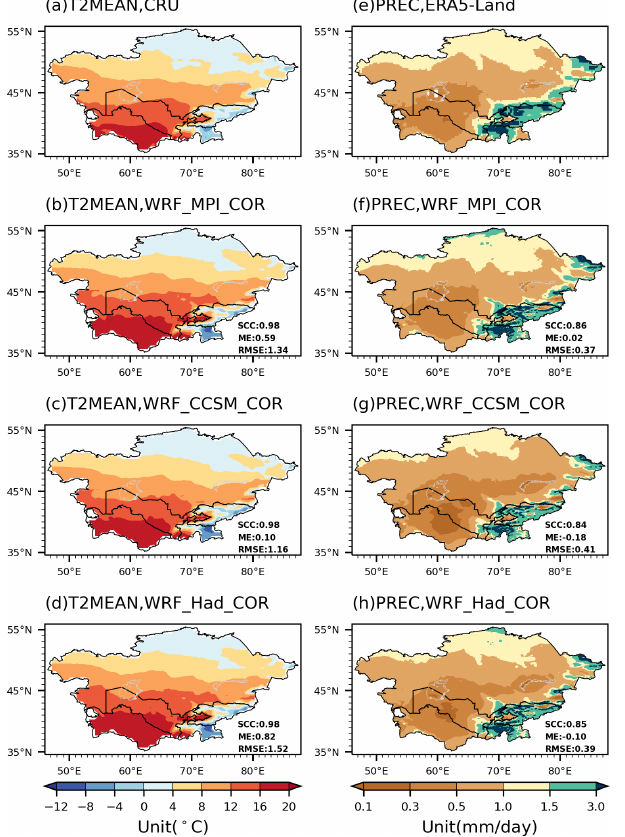
Figure 3. The observed and simulated annual mean T2MEAN and PREC in central Asia during the reference period (1986–2005). The spatial correlation coefficient (SCC), mean error (ME), and root mean square error (RMSE) are listed.